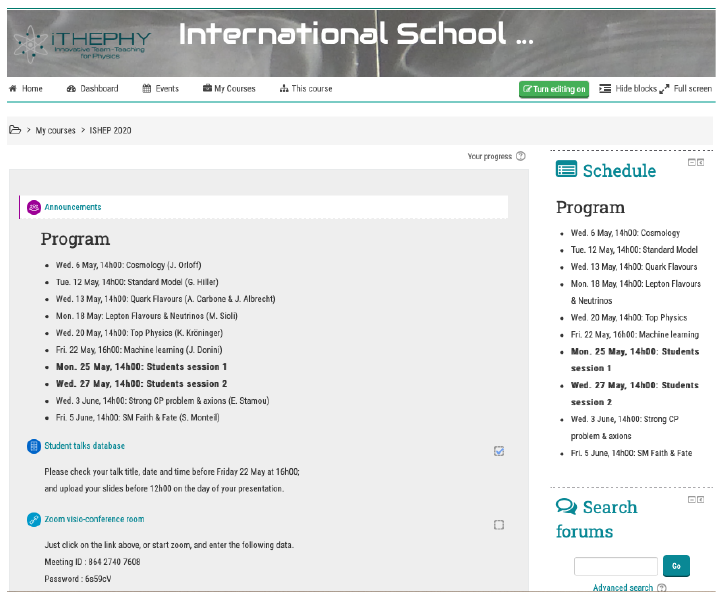
Figure 1. A view of the Moodle web